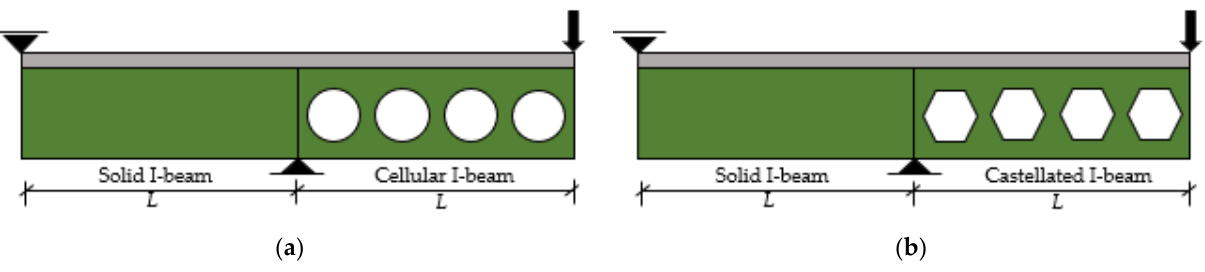
Figure 17. Analyzed beams: ( a ) C4S355 and C4S420; ( b ) H4S355 and H4S420. Adapted from [58]. Table 9. Geometric parameters of the specimens (in mm and mm 2 ).